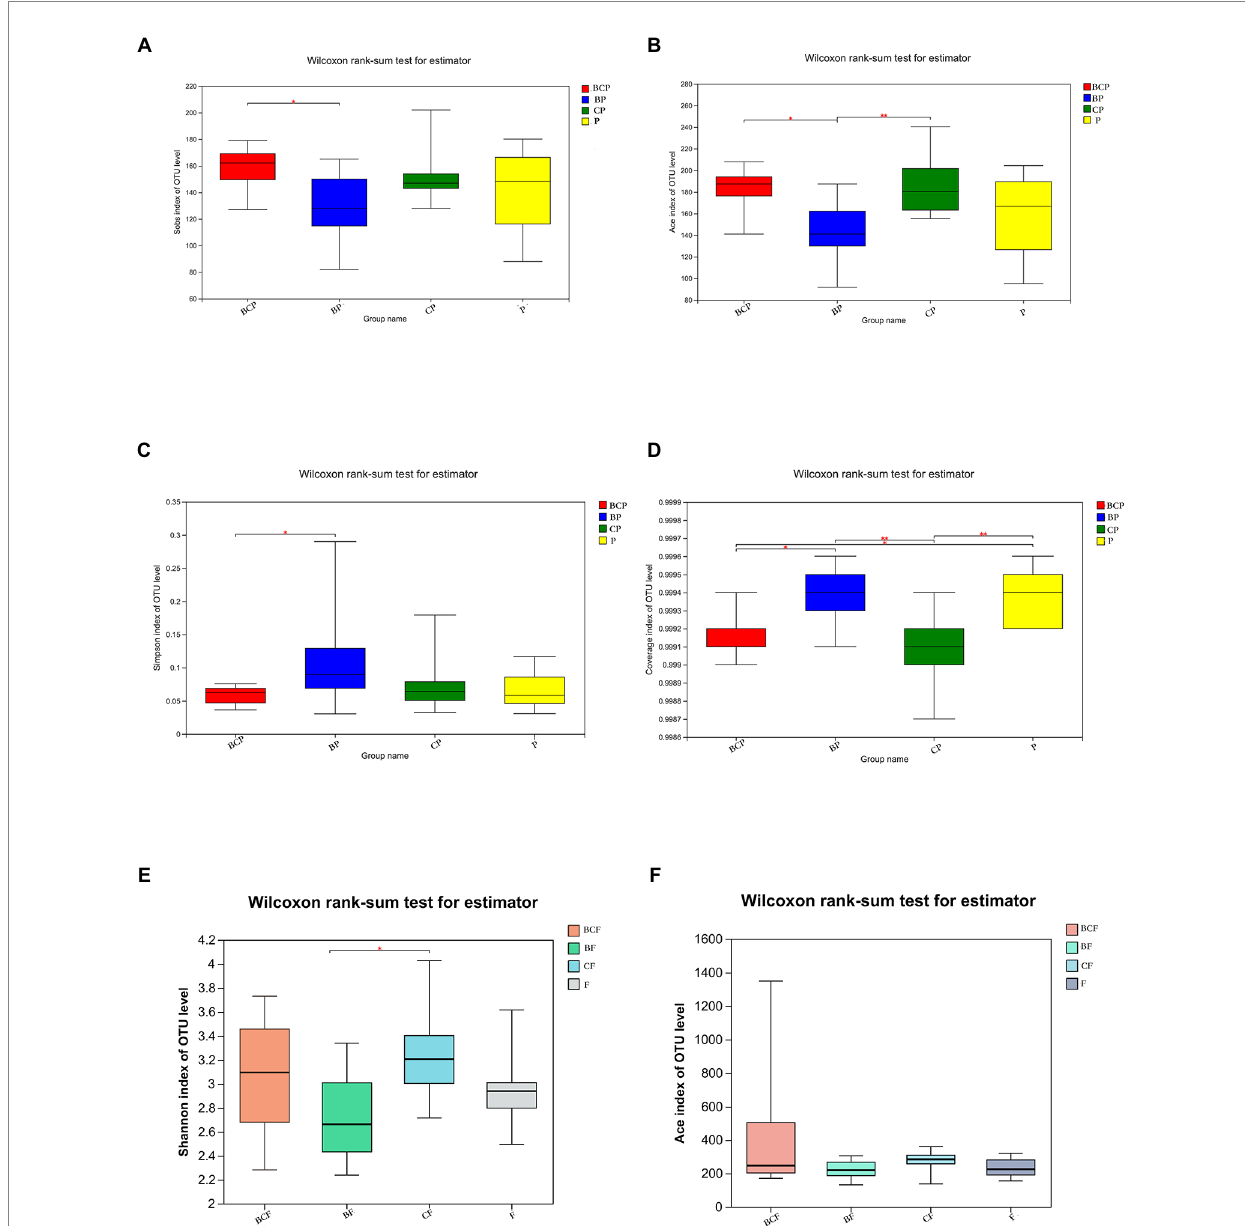
FIGURE 3 Comparison of α -diversity using the (A) Sobs Index, (B) Ace Index, (C) Simpson Index, (D) Coverage Index, (E) Shannon Index and (F) Ace Index. * p < 0.05, ** p < 0.01, *** p <